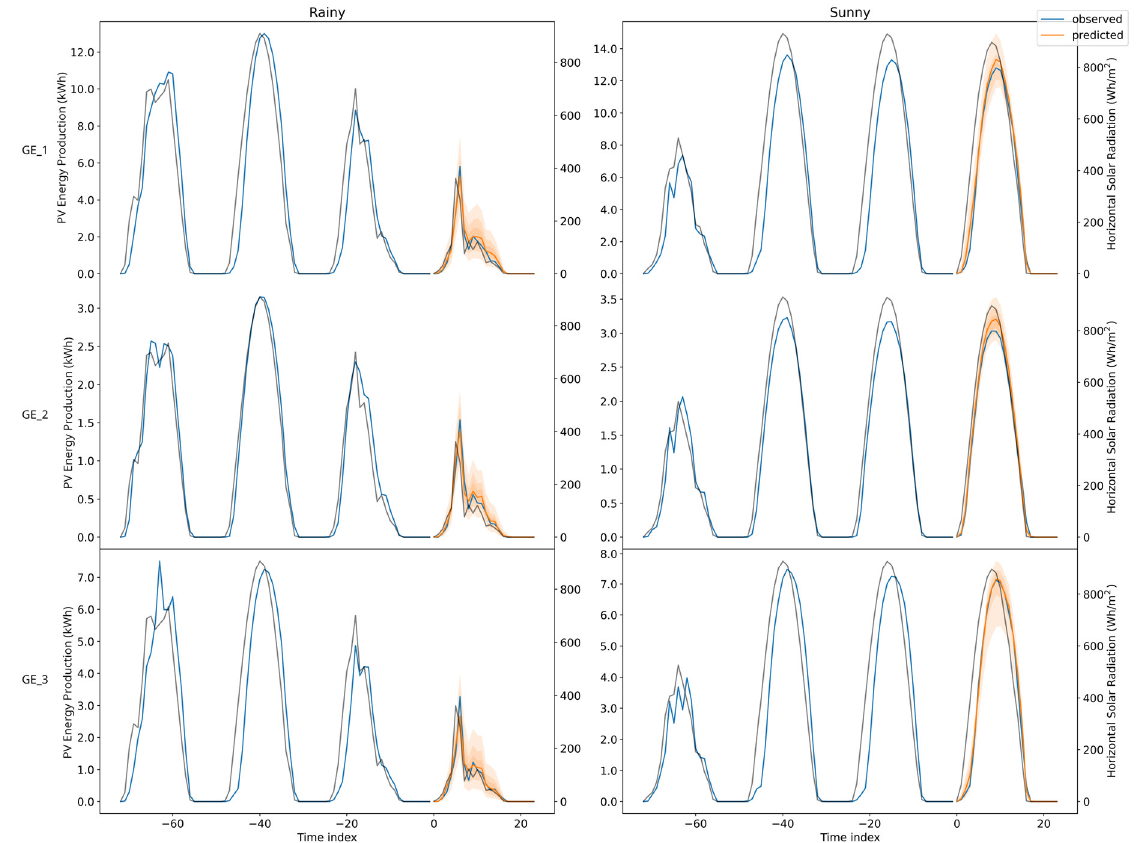
Figure 11. Observed and predicted PV energy production forecasting for a sunny and a rainy day in the facilities from Germany. Global horizontal irradiation is represented in grey.